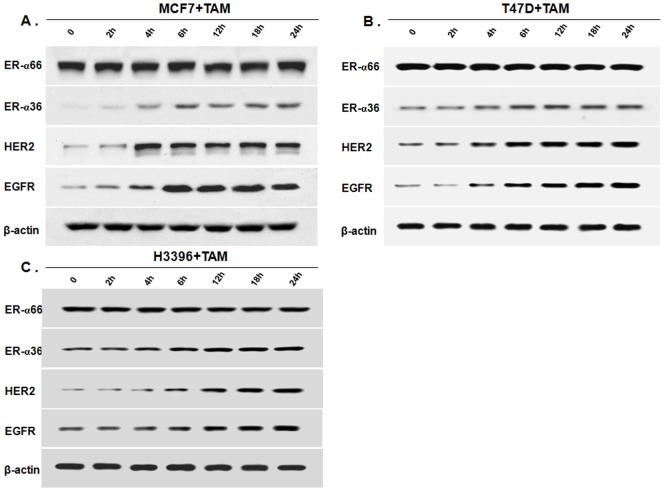
Tamoxifen induces ER-α36, HER2 and EGFR expression.Western blot analysis of the expression levels of ER-α66, ER-α36, HER2 and EGFR in ER-positive breast cancer MCF7 (A), T47D (B) and H3396 (C) cells treated with 1 µM of tamoxifen (TAM) for indicated time period.